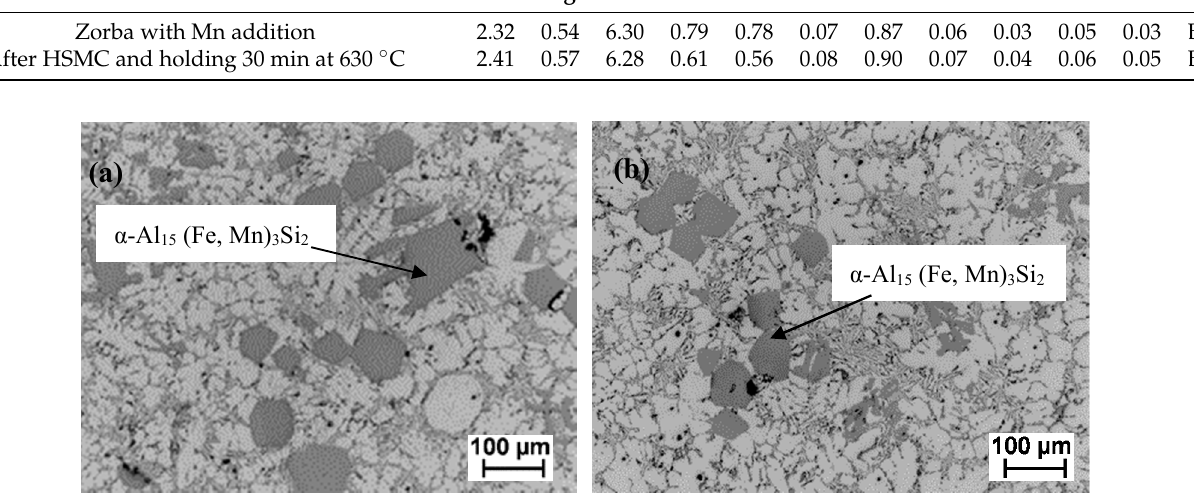
Figure 7. Optical micrographs of modified aluminum alloy recovered from the as-received Zorba cast fraction with 0.8% Mn; ( a ) before de-ironing, ( b ) after HSMC de-ironing.